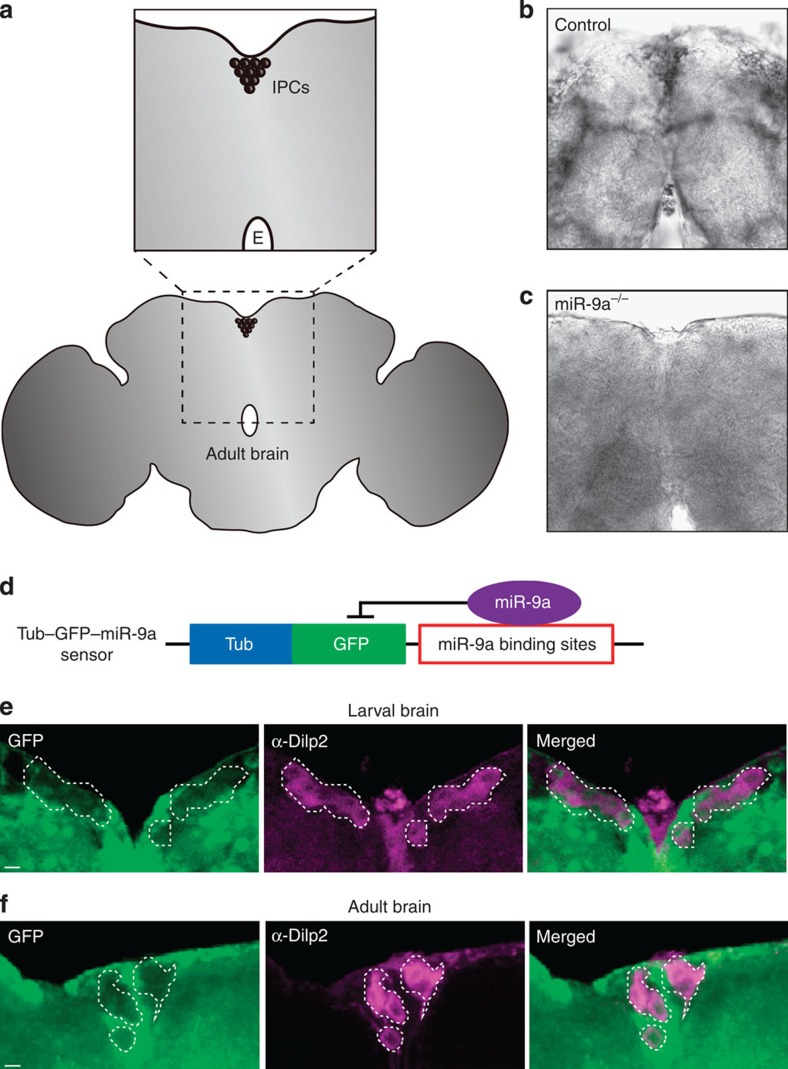
miR-9a
is expressed in the insulin-producing cells.(a) Adult brain schematics indicate the position of the IPCs in the median neurosecretory cluster in the pars intercerebralis. The ‘E' indicates the oesophagus. An in situ hybridization with an LNA probe specific to the mature miR-9a sequence stains the IPCs in the w1118 control genotype (b), but not in miR-9aE39/J22
null mutant (miR-9a−/−) brains (c). (d) A Tubulin–GFP–miR-9a sensor schematic. (e,f) The Tubulin–GFP–miR-9a sensor shows reduced GFP fluorescence in both the larval (e) and adult (f) IPCs, which are marked by an anti-Dilp2 antibody and with dotted white lines. Scale bar, 10 μm.